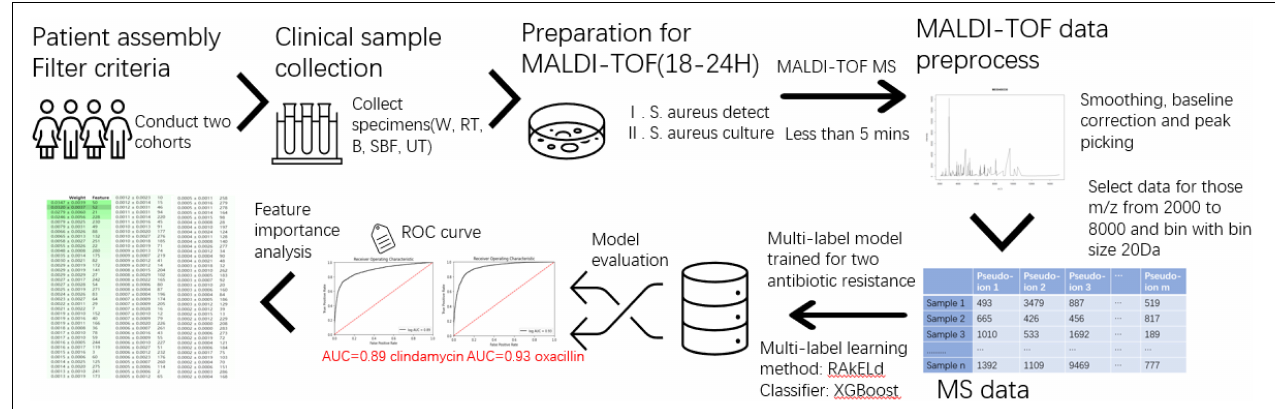
FIGURE 1 | Overview of the study. The flowchart mainly contains sample collection, matrix-assisted laser desorption-ionization-time-of-flight mass spectrometry (MALDI-TOF) process, and multi-label model construction and evaluation.